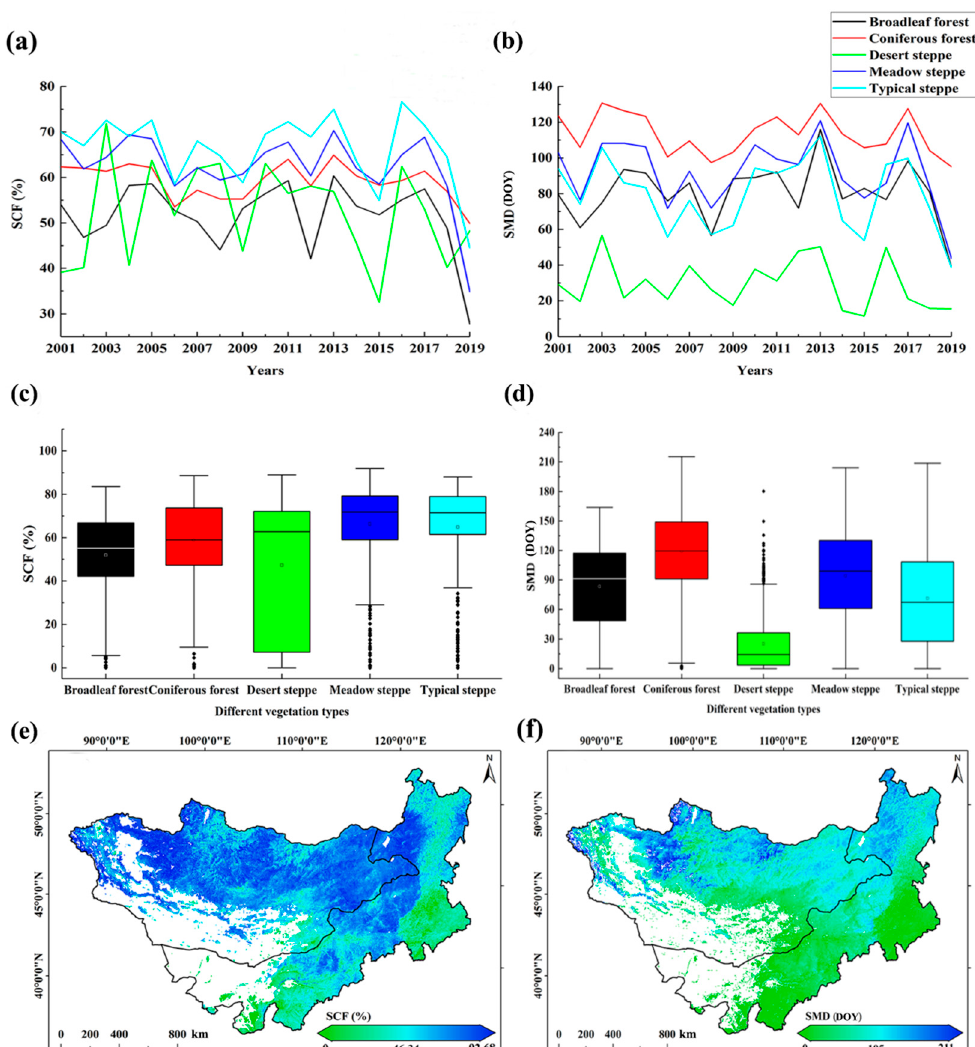
Figure 2. Different vegetation types of 2001–2019 SCF Winter and SMD Spring over the Mongolia Plateau: ( a ) SCF Winter change trend; ( b ) SMD Spring change trend; ( c ) SCF Winter spatial statistics box plot; ( d ) SMD Spring spatial statistics box plot; ( e ) distribution of average SCF Winter spatial map; ( f ) distribution of average SMD Spring spatial map.